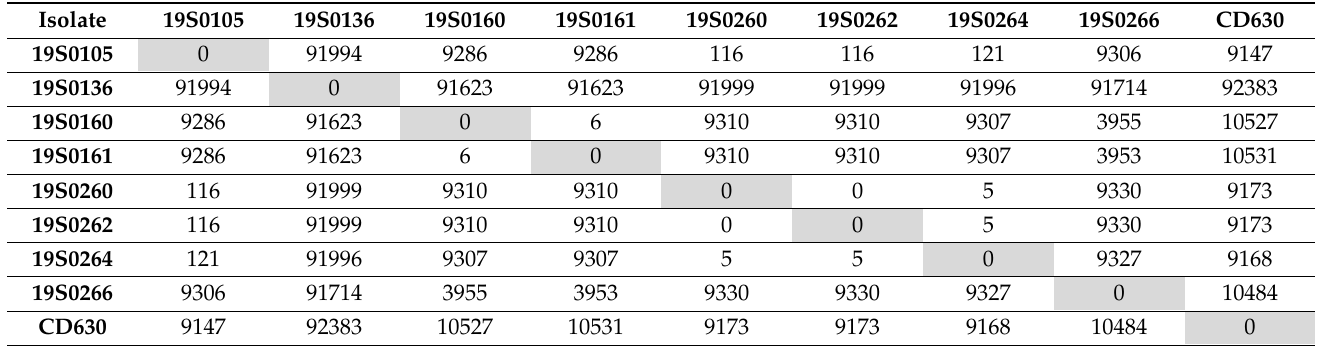
Table 2. Pairwise single nucleotide polymorphisms (SNPs) between the eight Clostridioides ( C .) difficile isolates.